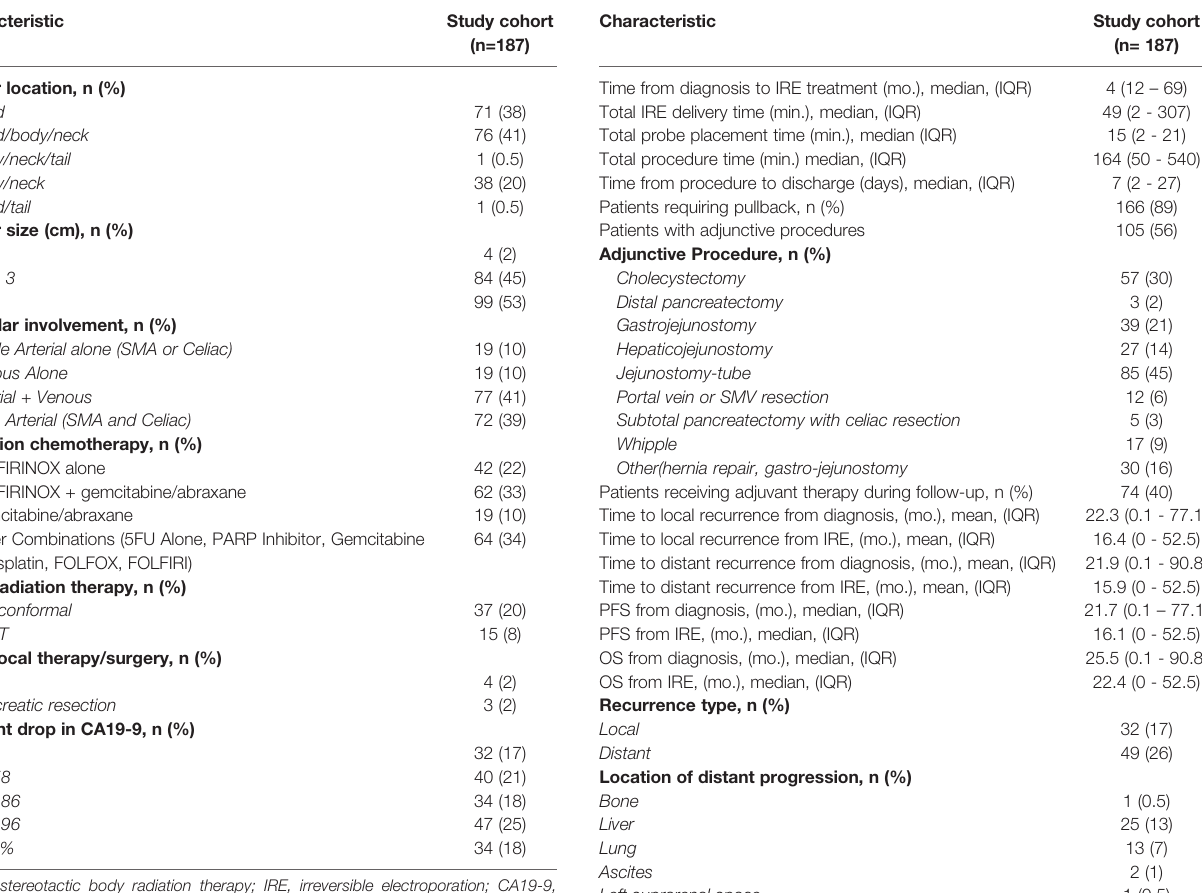
TABLE 2 | Tumor characteristics and neoadjuvant interventions. TABLE 3 | Operative characteristics, adjunctive procedures, and outcome